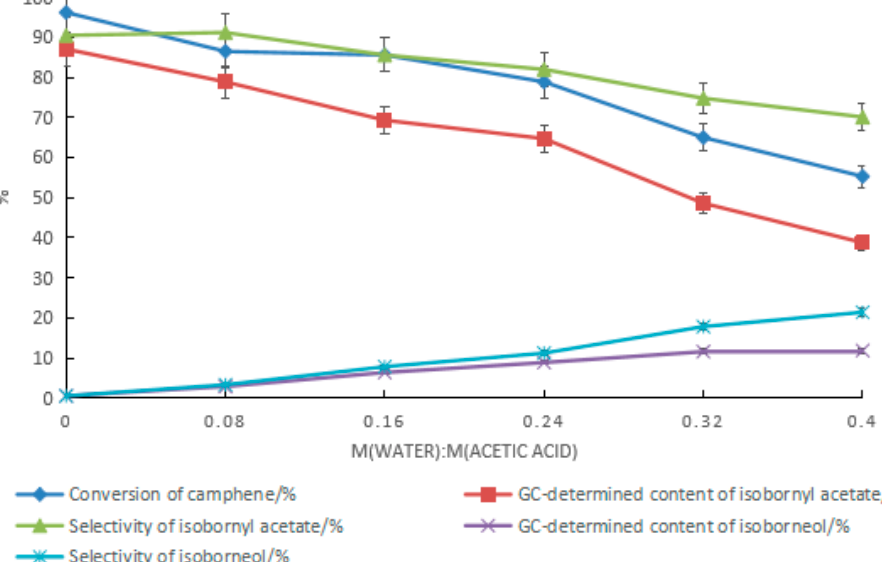
Figure 10. Effect of changes in the ratio of water to acetic acid on the product. Reaction conditions: m(camphene):m(acetic acid):m(tartaric acid):m(boric acid) = 10:25:1.5:0.4, reaction temperature of 70 °C, and reaction time of 24 h.